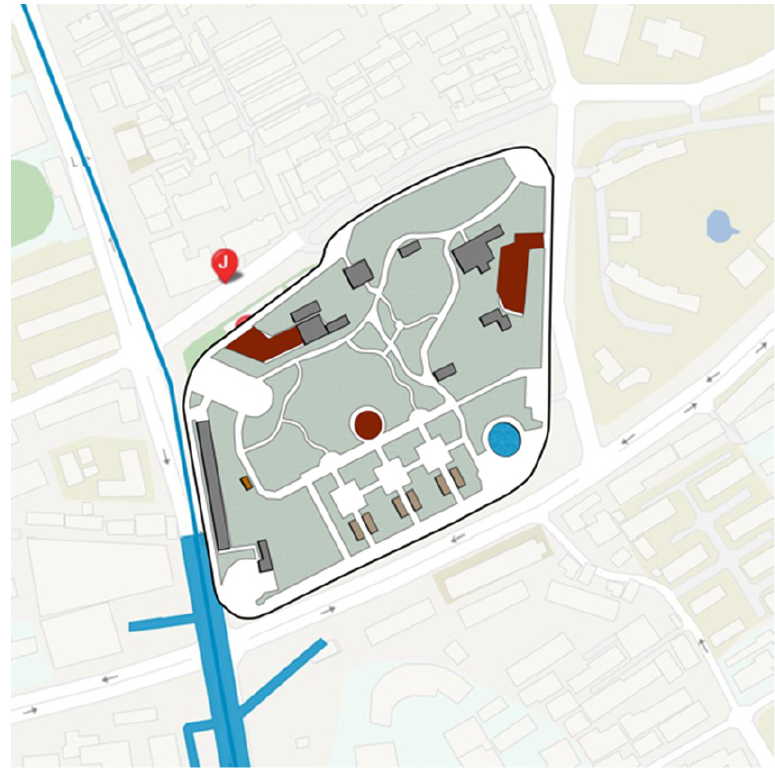
Figure 2. Map of Zhongxin Greenland.